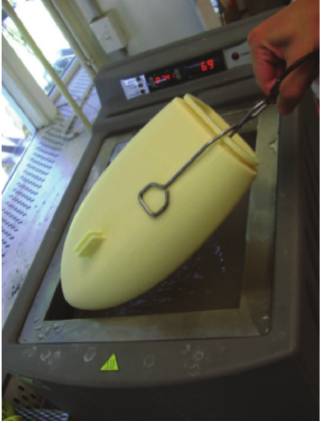
Figure 5: Dissolving support material.